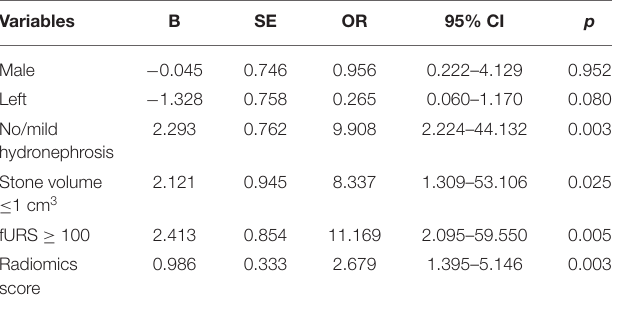
TABLE 4 | Multivariate analysis of the influencing factors on the success rate after fURS in lower calyx patients.